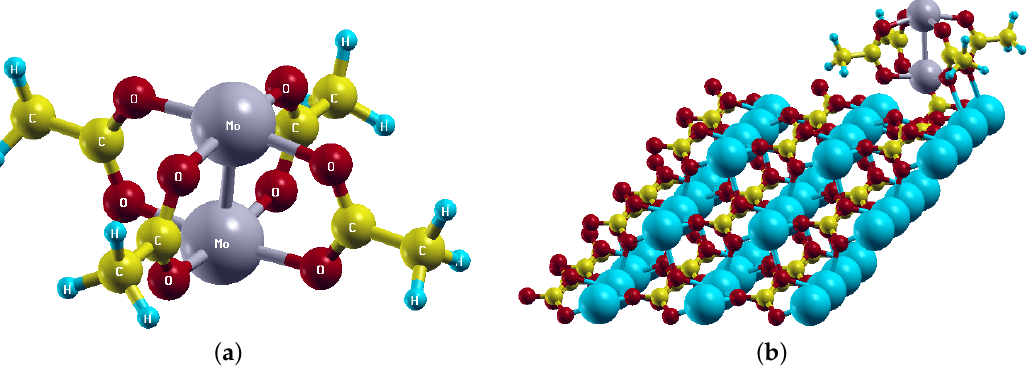
Figure 1. The structure of the dimolybdenum tetraacetate (MoMo) ( a ) in the gas phase and ( b ) as adsorbed on the three-layers slab model of the calcite (10.4) surface. The chemical species are indicated at the center of each atomic ball in ( a